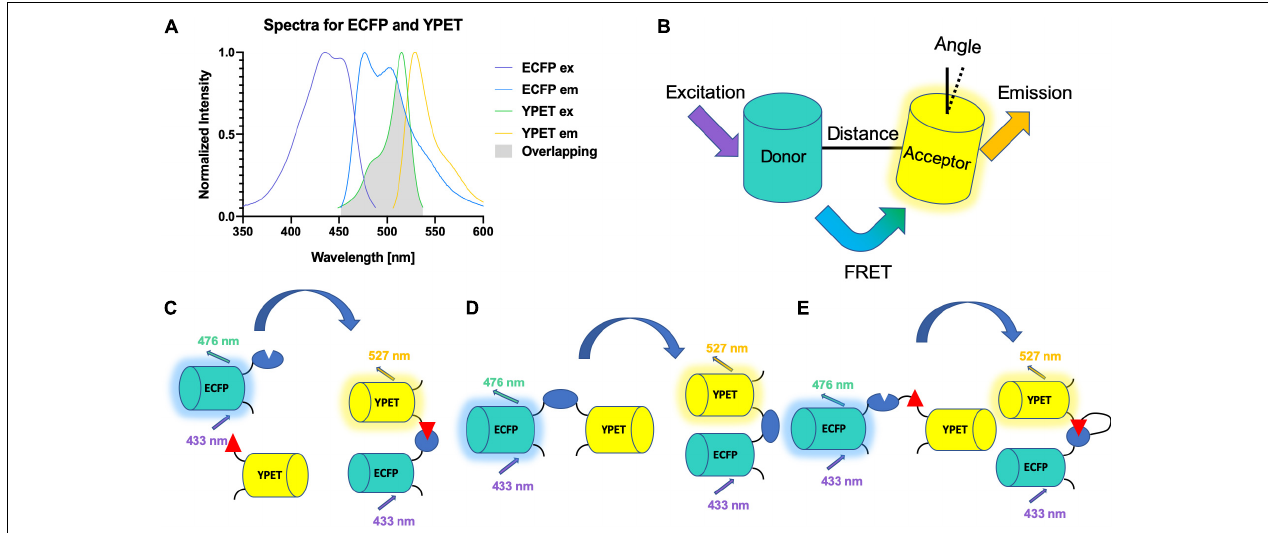
FIGURE 2 | Schematics for FRET biosensors. (A) Spectra of YPET and ECFP. The spectra of YPET and ECFP, a popular FP pair for FRET biosensor, is shown here. A large overlap between the emission spectrum of the donor and the excitation spectrum of the acceptor is crucial for the success of a FRET biosensor. (B) Distance and orientation of FRET pair. A short distance and correct orientation (not orthogonal) are necessary for the efficiency of the energy transfer. (C) A schematic for an intermolecular FRET biosensor that detects binding of two domains. (D) A schematic for an intramolecular FRET biosensor that detects change of conformation of one domain. (E) A schematic for an intermolecular FRET biosensor.